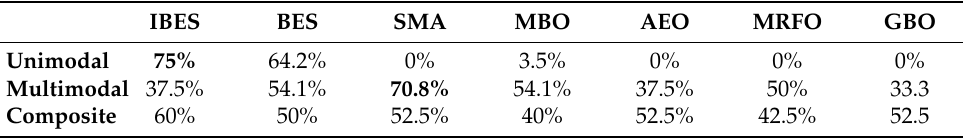
The bold indicates to the highest